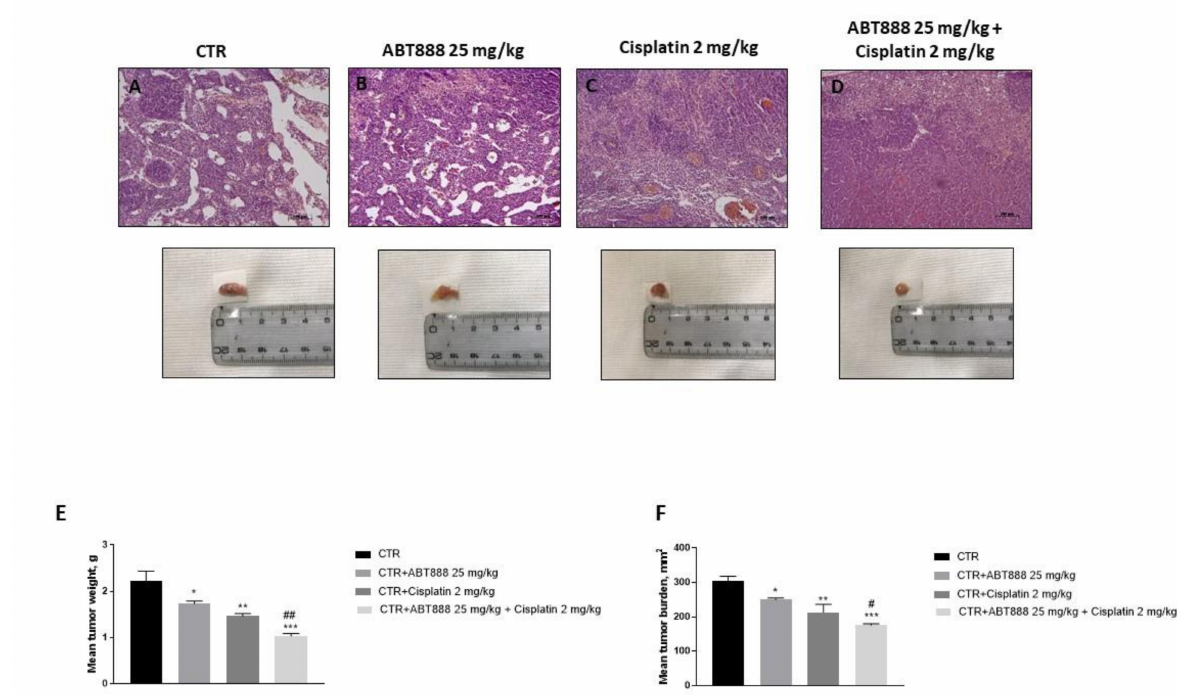
Figure 10. Effect of ABT888 and cisplatin on tumor growth. HE staining showed that the association between ABT888 and cisplatin significantly reduced tumor sections ( D ) much more than single components ( B , C ), compared to control group ( A ). Moreover, the association of ABT888 and cisplatin significantly reduced tumor weight as well as tumor burden ( E , F ). Data are representative of at least three independent experiments. ( E ) * p < 0.05 vs. the control; ** p < 0.01 vs. the control; *** p < 0.001 vs. the control; ## p < 0.01 vs. cisplatin group. ( F ) * p < 0.05 vs. the control; ** p < 0.01 vs. the control; *** p < 0.001 vs. the control; # p < 0.05 vs. cisplatin